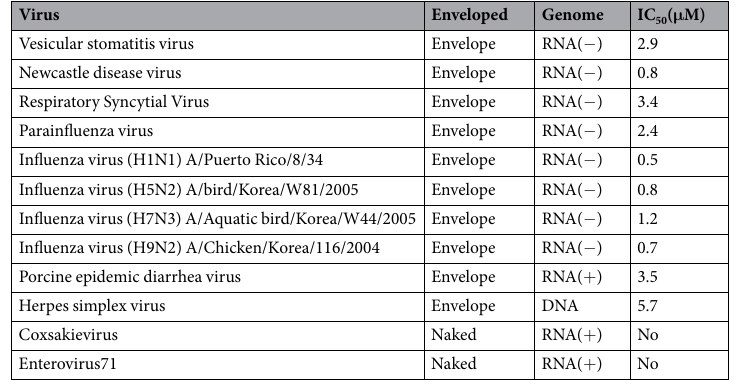
Table 2. Virocidal effect of TAT-K α 2 peptide against various